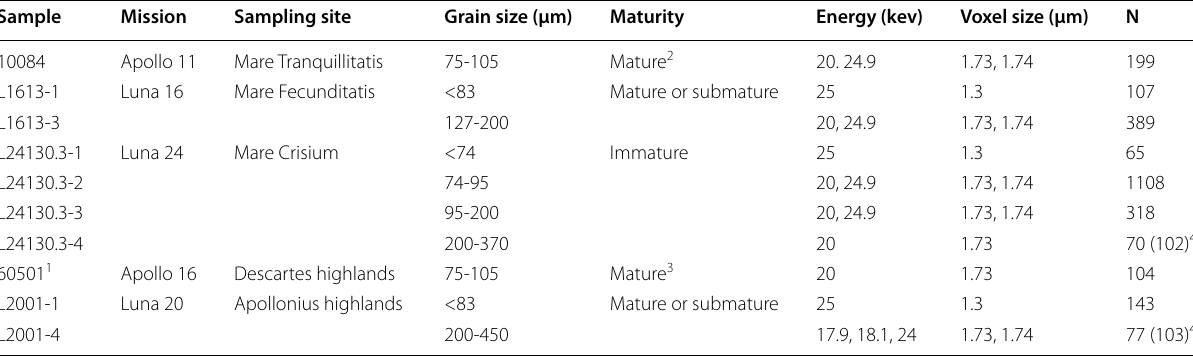
1 Particles of 105–250 μm in size also examined with microtomography by Katagiri et al. (2014) 2 Is/FeO 78 (Morris et al. 1978) = 3 Is/FeO 80 (Morris et al. 1978) = 4 Small particles that might be formed by fragmentation after sieving were omitted in the analysis (the total number of the particles measured are shown in